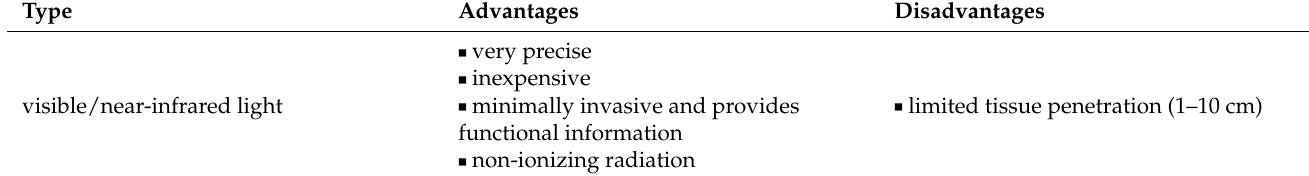
Table 1. The advantages and disadvantages of drug delivery trigger mechanisms.